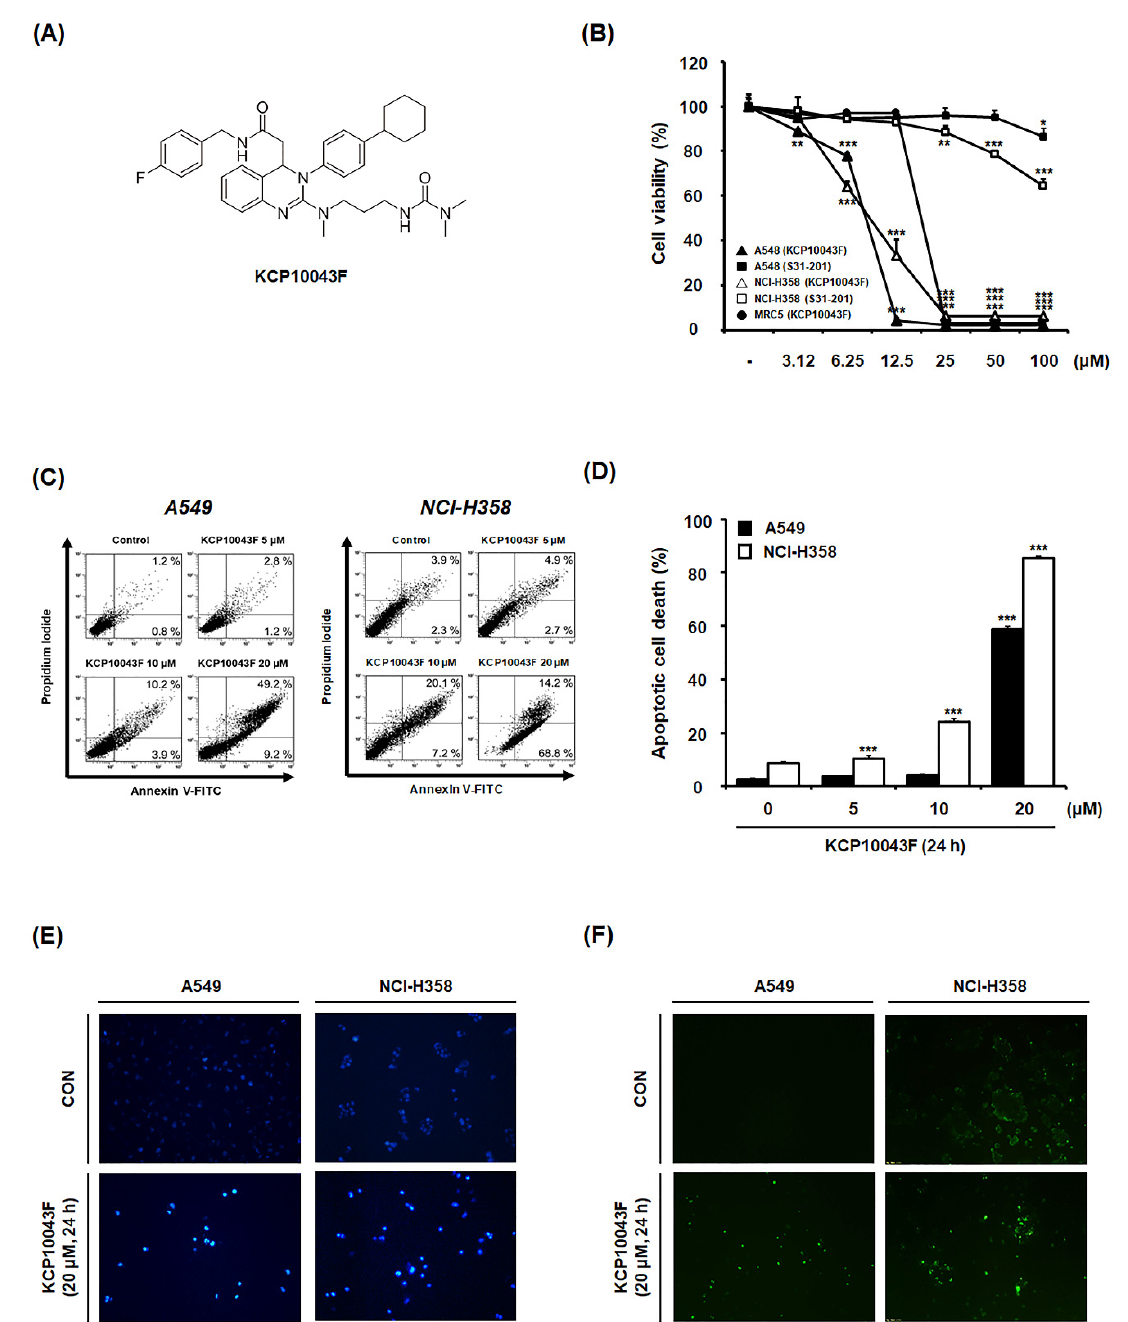
Figure 1. Induction of apoptosis by KCP10043F in A549 and NCI ‐ H358 cells. ( A ) Structure of KCP10043F. ( B ) A549, NCI ‐ H358, and MRC5 cells were treated with KCP10043F (3.12–100 µM) for 48 h. S3I ‐ 201 (3.12–100 µM) was used as a positive control with A549 and NCI ‐ H358 cells. ( C) A549 and NCI ‐ H358 cells were treated with KCP10043F (5, 10, or 20 µM) for 24 h and co ‐ stained with propidium iodide (PI) and fluorescein isothiocyanate (FITC) ‐ conjugated annexin V for detecting apoptosis by flow cytometry. ( D ) The portion of early apoptosis (Annexin + /PI − ) cells and late apoptosis (Annexin + /PI + ) cells in the graph is determined as apoptotic cell death rate. ( E,F ) A549 and NCI ‐ H358 cells were treated with 20 µM KCP10043F for 24 h. DNA fragmentation was detected by DAPI and TUNEL assay. Data represent the mean ± standard deviation (SD) of the results from three independent experiments. ** p < 0.01, *** p < 0.001 vs. untreated control group.